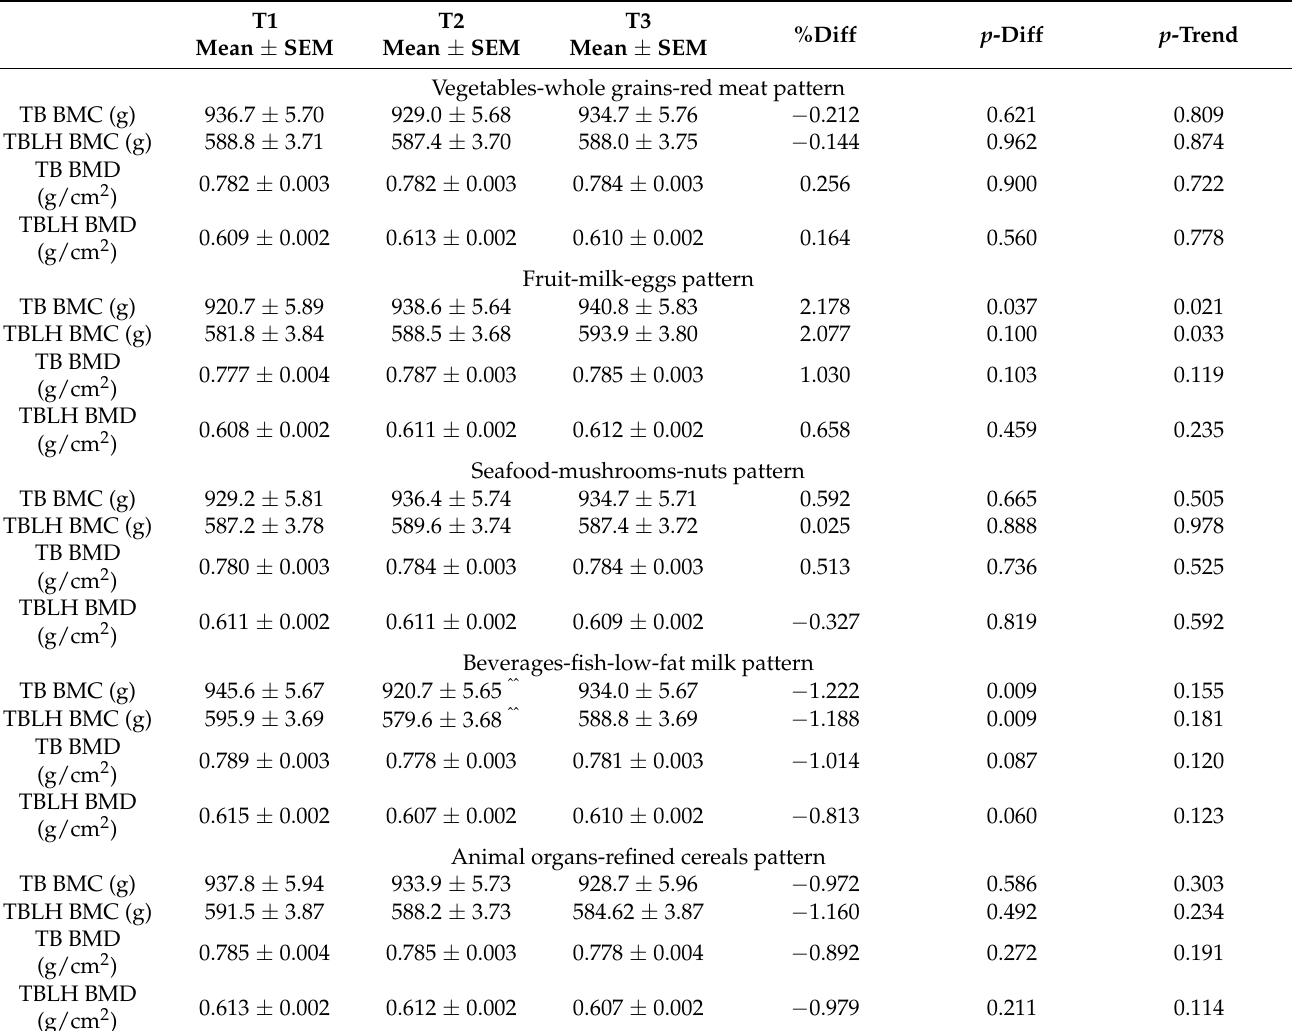
Table 4. Covariate-adjusted mean of BMC and BMD by tertiles (T) of energy-adjusted dietary pattern scores